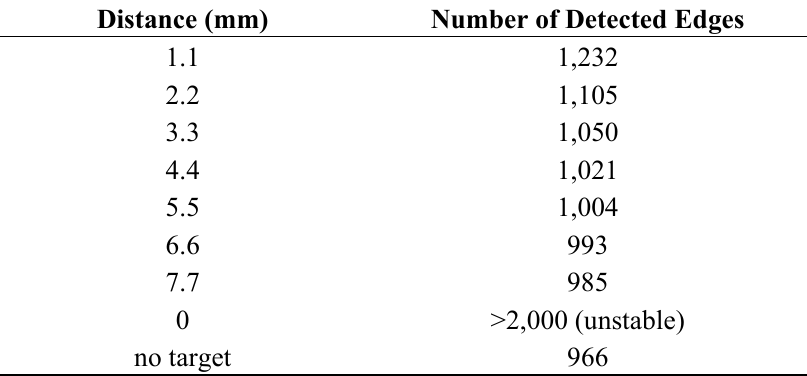
Table 2. The number of detected rising edges as a function of the